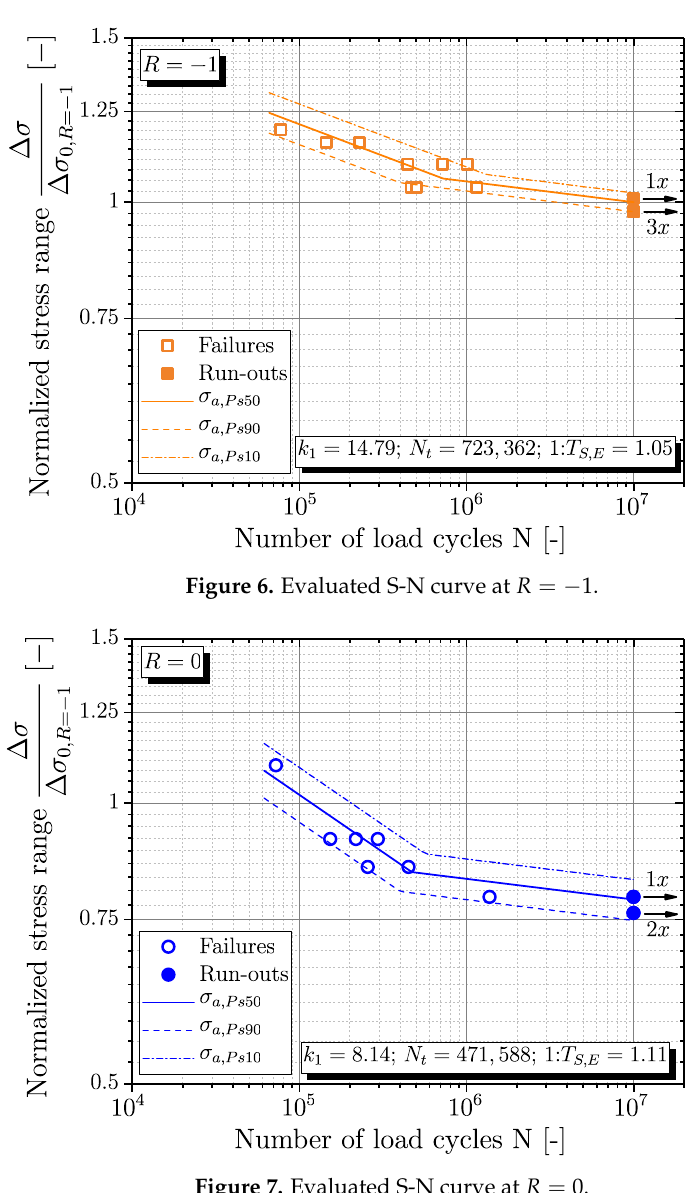
Figure 7. Evaluated S-N curve at R =